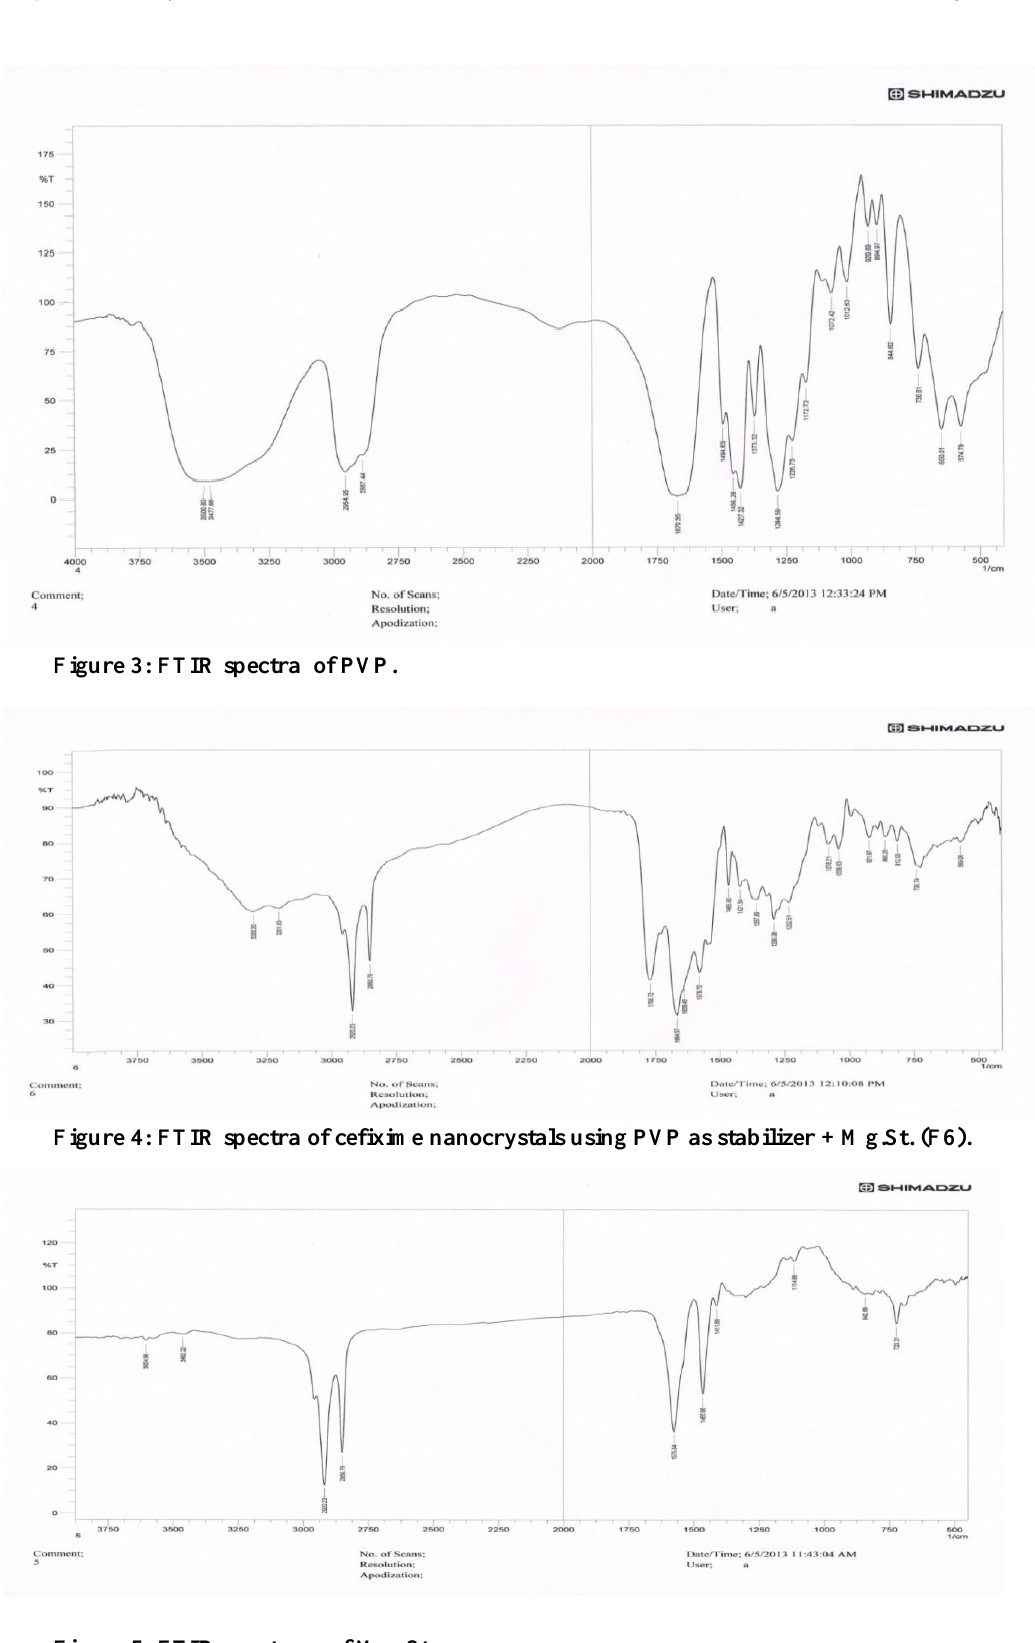
Figure 5: FTIR spectrum of Mg.